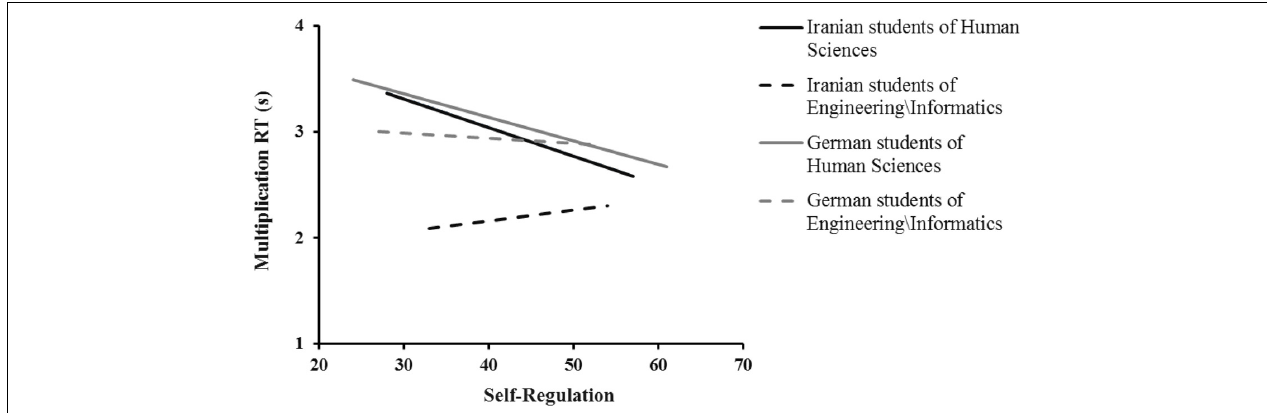
FIGURE 1 | Linear regression trend lines testing the relation of self-regulation as predictor and multiplication RT as the dependent variable in four different subsamples: German students of Human Sciences, German students of Engineering/Informatics, Iranian students of Human Sciences, and Iranian students of